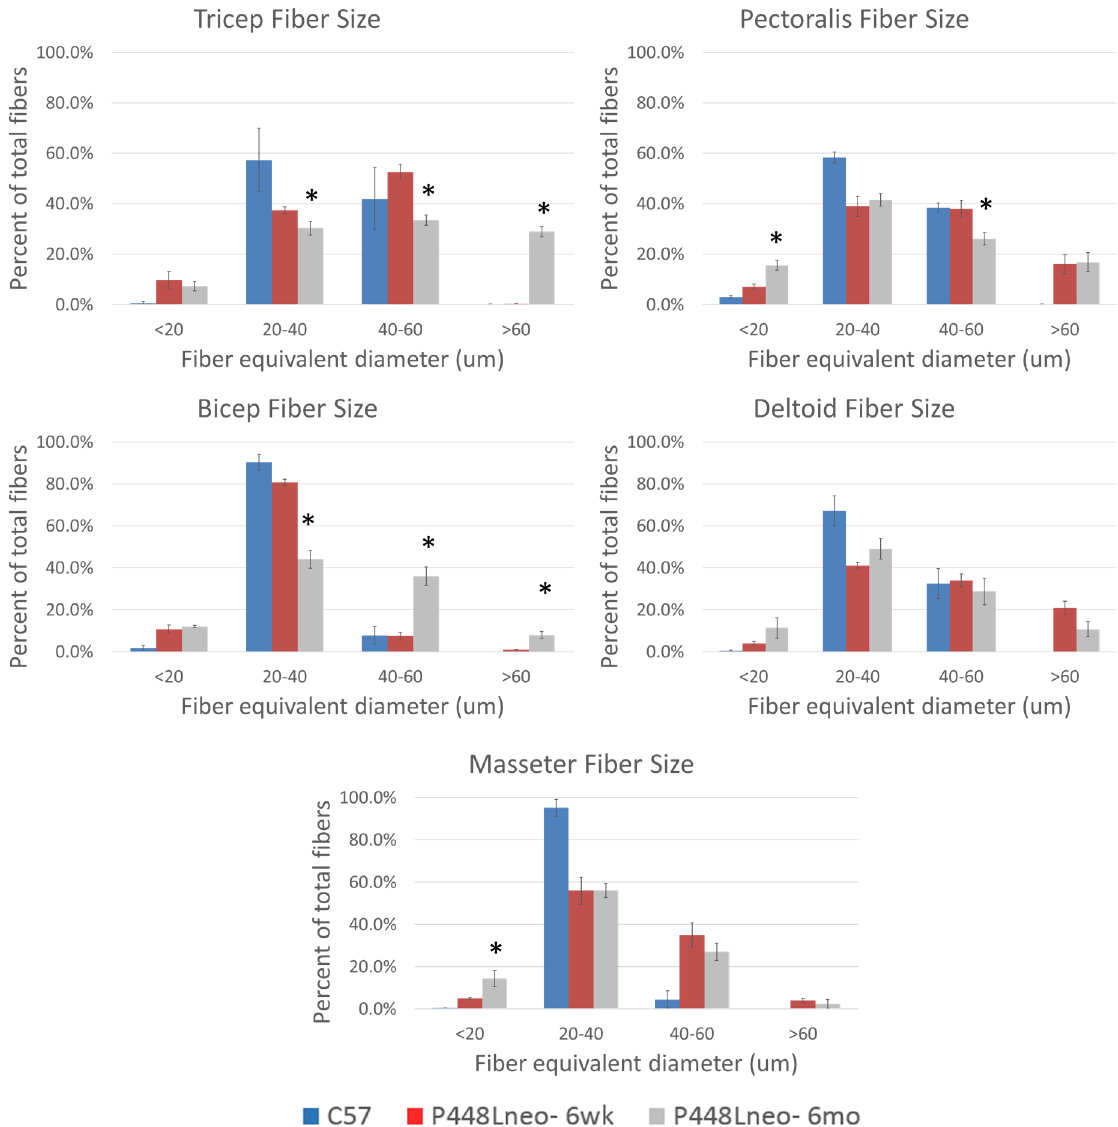
Fig 4. Fiber size of forelimb, trunk and head muscles of P448Lneo- mutant mouse. An increase in muscle fiber diameter is clear in both triceps and biceps with little to no increase in smaller diameter fibers. However, pectoralis, deltoid and masseter show an increase in fibers with small diameter, < 20 micron. Significant difference between 6 weeks and 6 months noted with (cid:3) . Significance determined as p < 0.05.